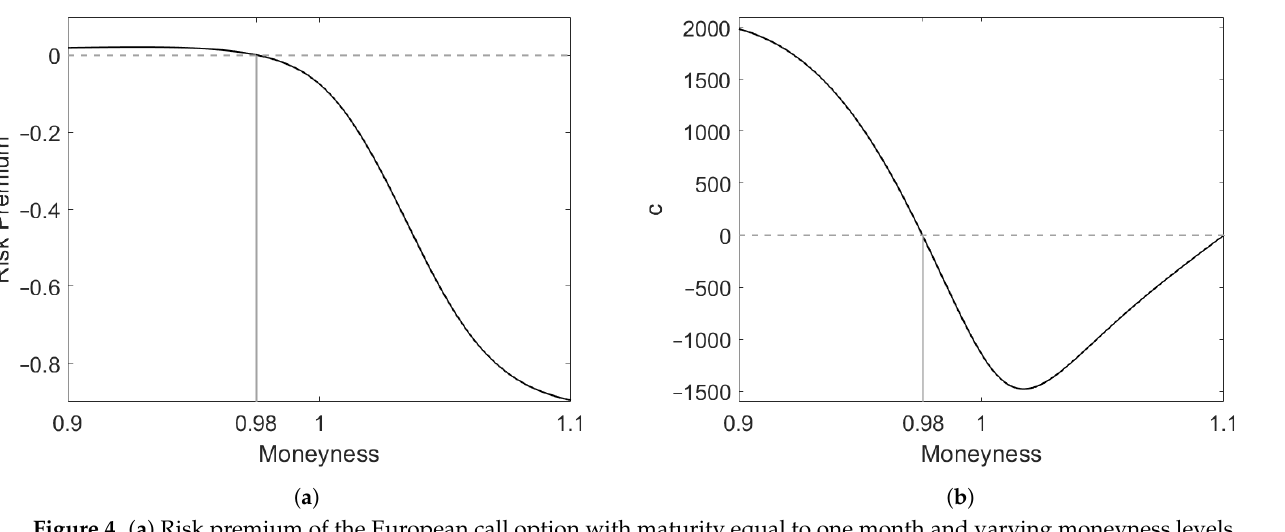
Figure 4. ( a ) Risk premium of the European call option with maturity equal to one month and varying moneyness levels. The underlying asset is the S&P500 index on 15 March 2018. The zero-risk premium moneyness level amounts around 98% of the spot price. ( b ) The difference in expected payoff under the P - and Q -probability measures, as defined by function c in Equation (12). ( a ) Risk Premium; ( b ) Difference in Expected